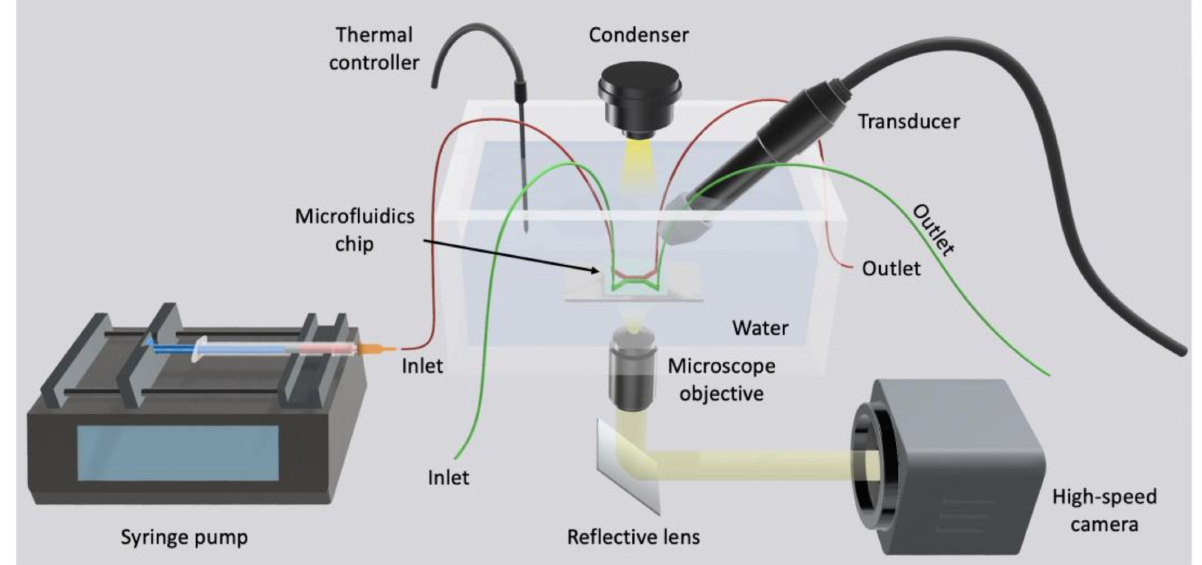
Figure 13. Schematic of a typical setup used for the ultrasound experiments with BOCs. The chips were placed in the water bath. Ultrasound was generated by the transducer placed at a 45 ◦ angle to the chip surface. A stroboscopic light source illuminated the chip while the high-speed camera captured the MB dynamics. The syringe pump perfused microbubbles into the chip. Different ultrasound parameters were used in these studies including ultrasound frequency, acoustic pressure/intensity, pulse duration, and duty cycle (see Table 2). It is worth noting that the flow rate in the BOC also affects the disruption of the vascular